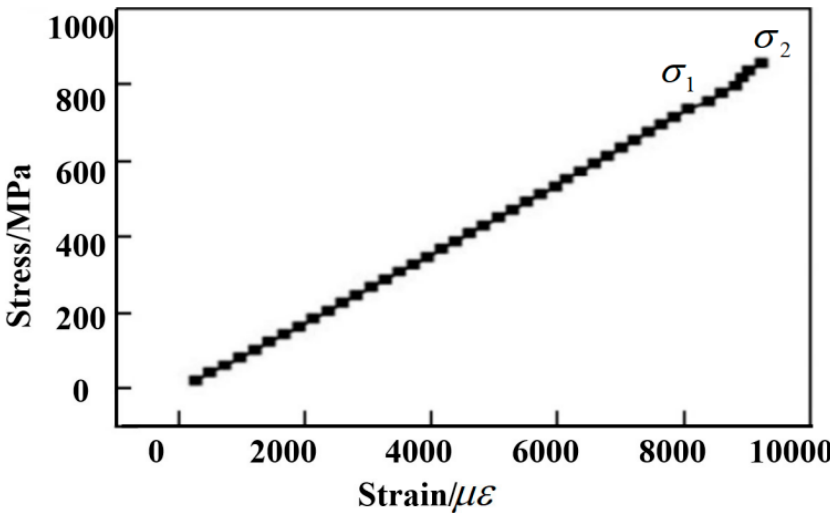
Figure 8. Stress–strain curve of axial tension.